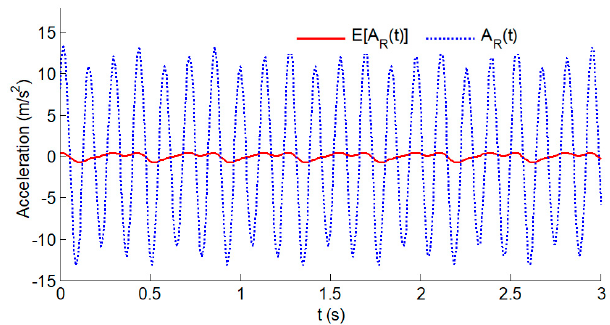
Figure 4. Displacement of the structure.